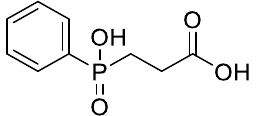
Figure 2. CEPPA structural formula.